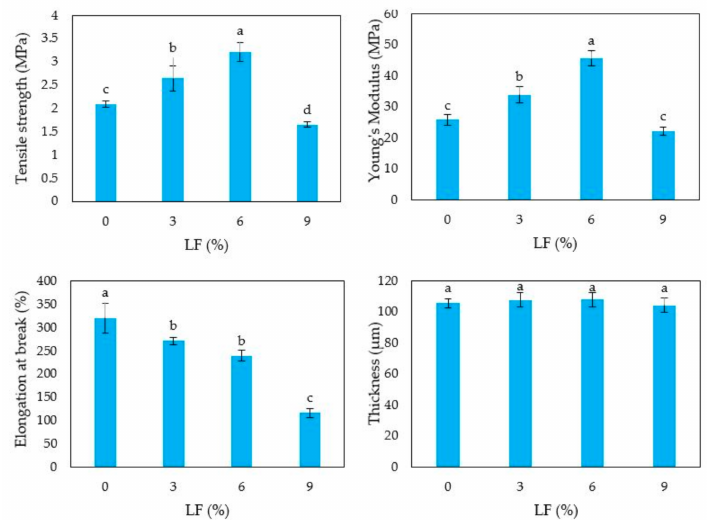
Figure 5. Tensile strength (TS), elongation at break (EB), Young’s module (YM) and thickness of hemp protein-based films derived from film forming solutions (FFSs) prepared at pH 12 and containing increasing concentrations of egagropili lignin fraction (LF). Di ff erent small letters a–d indicate significant di ff erences among the values reported in each column ( p < 0.05). Further experimental details are given in